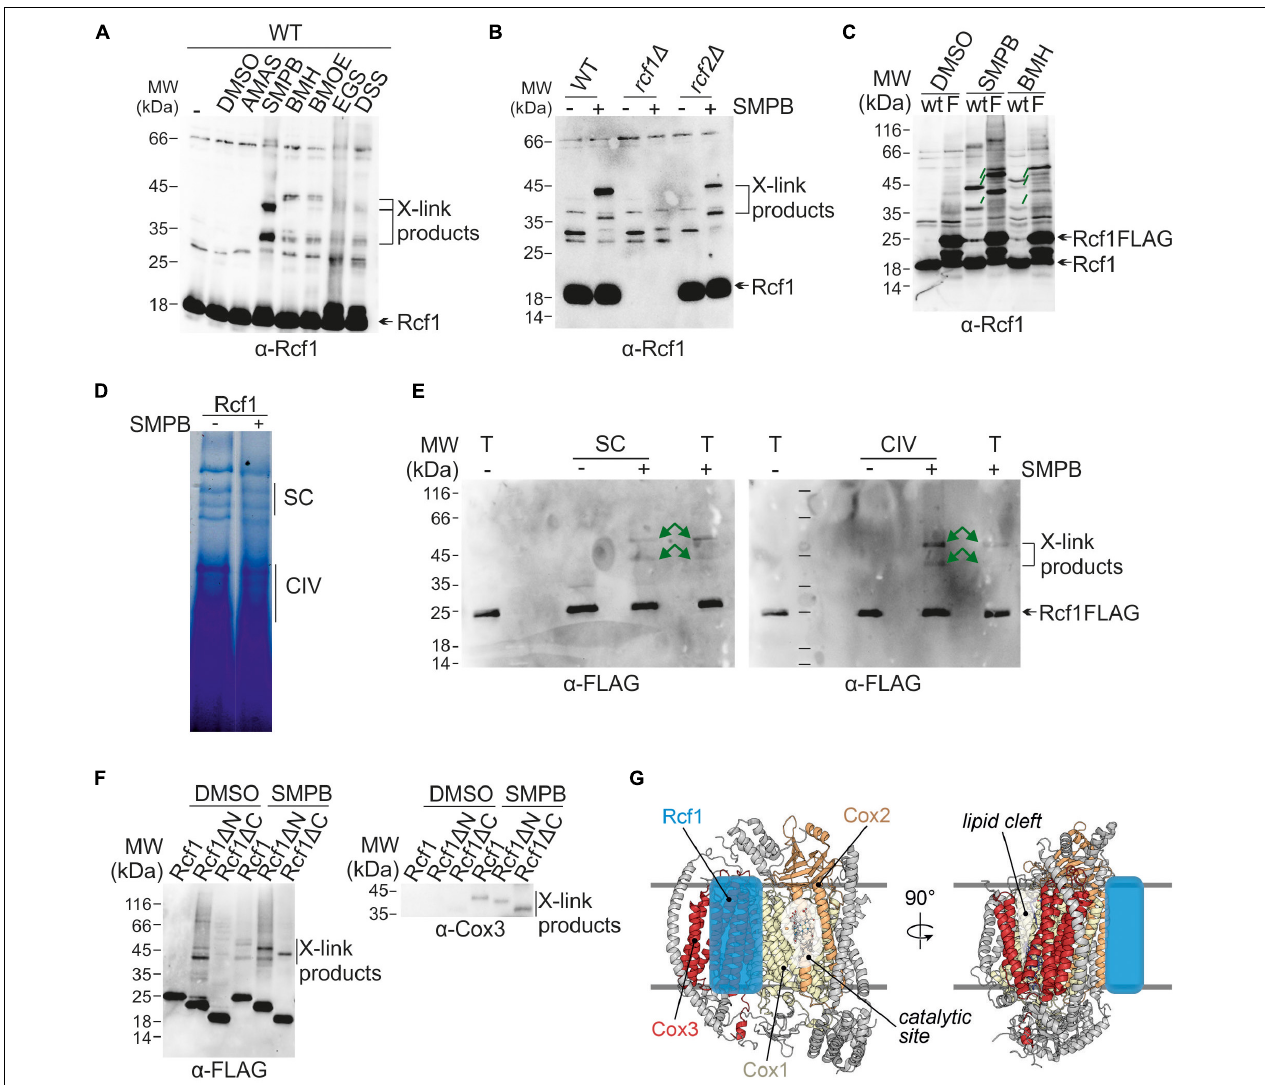
FIGURE 6 | Interaction partners and interaction sites of Rcf1. (A) Proteins in purified mitochondria were chemically crosslink followed by protein extraction, SDS-PAGE, Western blotting and immuno decoration against Rcf1. Use of different crosslink reagents (differences in reactive group and length) showed that Rcf1 has multiple interaction partners. The controls (-, DMSO) show cross reactions of the Rcf1 antiserum, which was considered during analysis in this and the following blots. (B) Chemical crosslink studies were performed as described in (A) with the crosslink reagent SMPB in the presence and absence of either Rcf1 or Rcf2 showed that the crosslink products were independent of Rcf2. (C) Chemical crosslink studies of Rcf1 or Rcf1FLAG with SMPB and BMH showed that all crosslink products of Rcf1 shift only 6 kDa (green lines), indicating that none of the crosslink products are self-crosslinks of a Rcf1 dimer. (D) Crosslinked (SMPB “+”) and non-crosslinked (SMPB “–“) mitochondria were solubilized in 2% digitonin and separated using BN-PAGE. The pattern of the supercomplexes was not affected by the crosslink. (E) As indicated in (D) gel samples containing either supercomplexes (SC) or cytochrome c oxidase (CIV) as well as total mitochondria fraction (T) were loaded on a polyacrylamide gel followed by transfer to a nitrocellulose membrane and immuno decoration. The crosslink pattern shows the same crosslink products in supercomplexes as in cytochrome c oxidase (green arrows). (F) Chemical crosslink studies with SMPB (DMSO as control) using the truncation mutants show interactions of both N- and C-termini with Cox3. The antibody against the FLAG-peptide showed unspecific binding in the control (DMSO), which was considered during analysis. (G) Model of Rcf1 binding to Cox3 of cytochrome c oxidase (adapted from PDB ID: 6HU9). We propose that Rcf1 either directly modulates the active site in Cox1, which is adjacent to Cox3, or Rcf1 modulates the lipid cleft and, thus, the active site through interaction with TM helices of